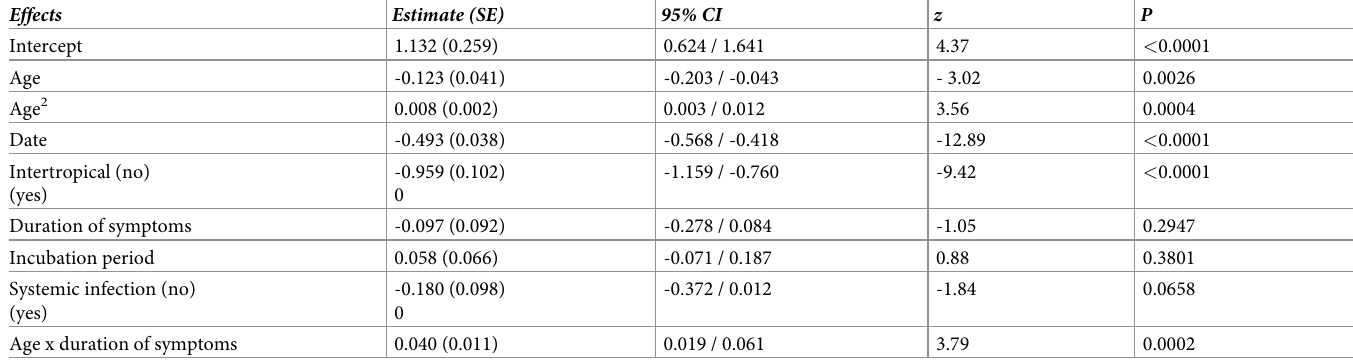
Table 2. Finite mixture model with a beta-binomial distribution of errors exploring the effect of duration of symptoms, incubation period and whether pathogens induce a local or a systemic infection on age-specific CFR (number of deaths/number of cases). The table reports the estimates (with SE and 95% CI), z and P values for the parameters retained in the model with the smallest BIC value. Number of observations = 873; number of deaths/number of cases = 143,877/5,624,790.